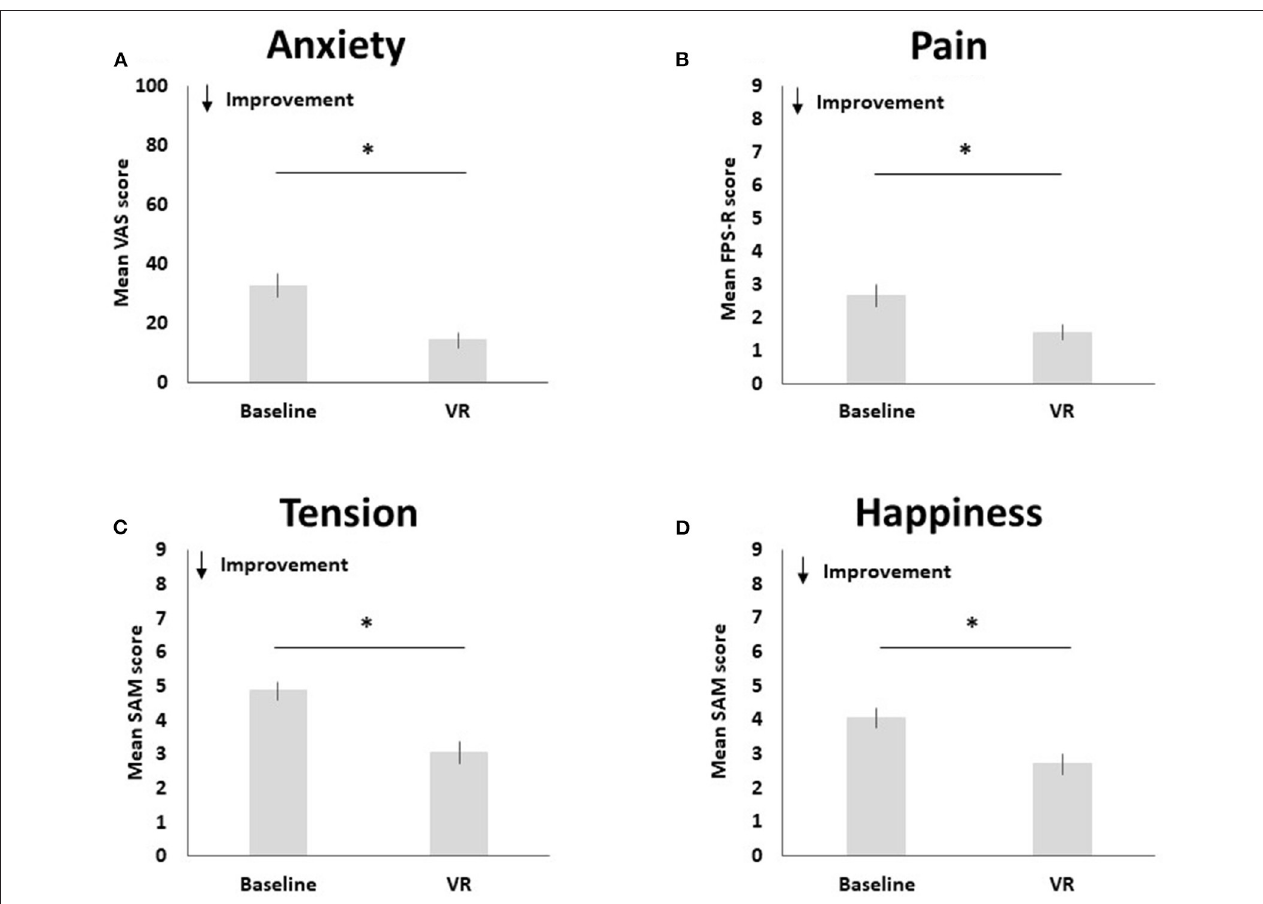
FIGURE 3 | Pre-to-post changes in anxiety (A) , pain (B) , tension (C) , and happiness (D) . The * symbol indicates the significant group difference at the significance level of p <